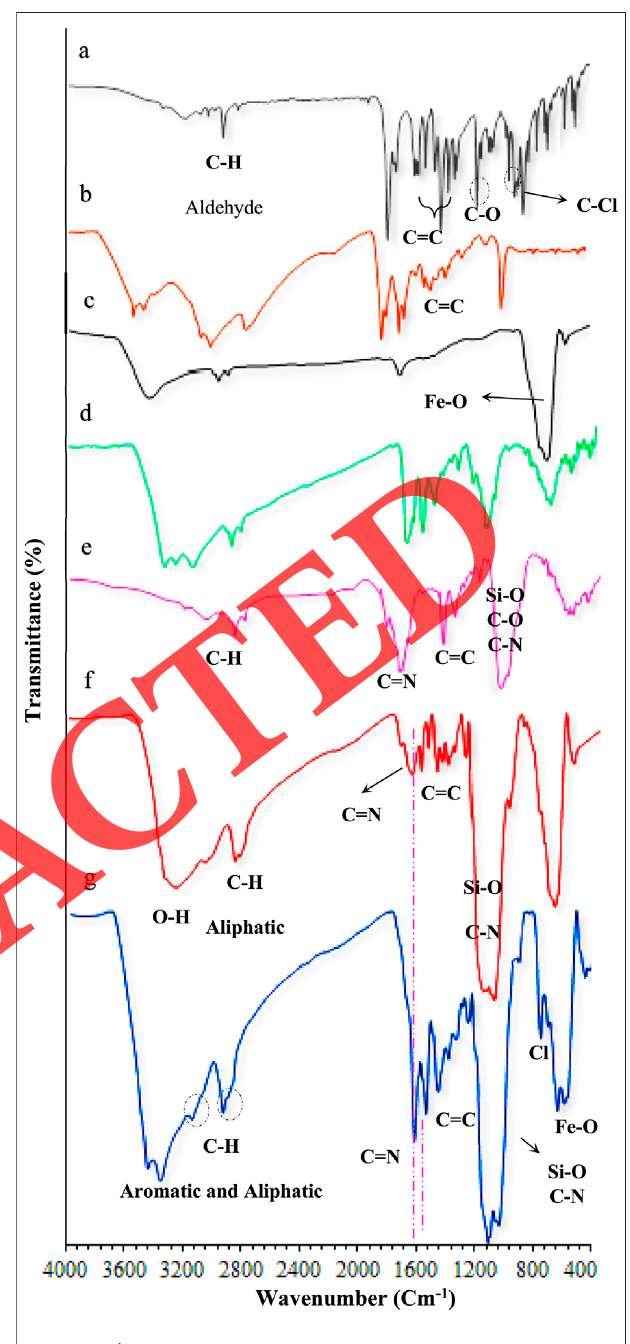
FIGURE 1 | FT-IR spectra of (A) 2-hydroxy-5-chloromethyl benzaldehyde, (B) SBL, (C) Fe 3 O 4 , (D) Fe 3 O 4 @CNF, (E) PTMS-Im,